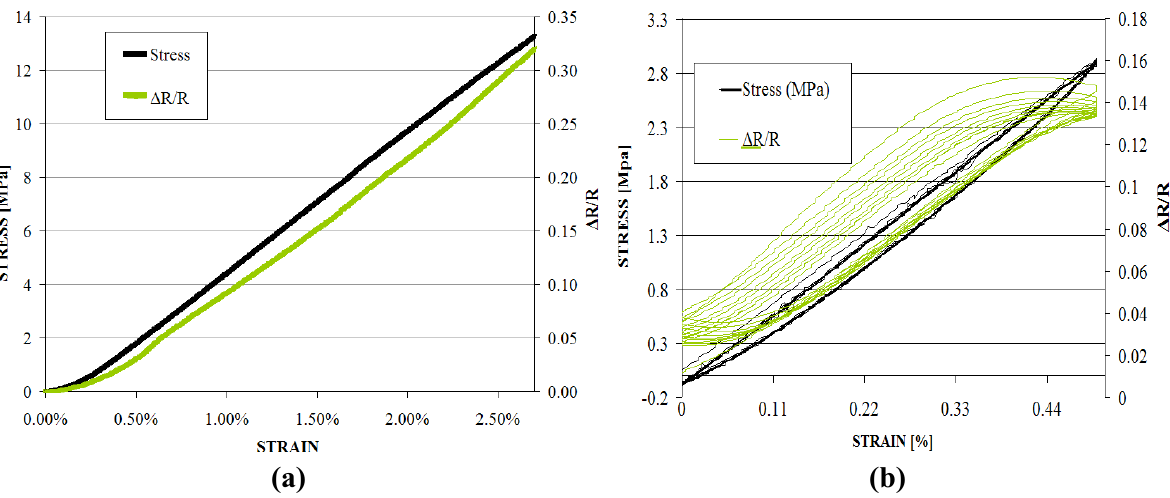
Figure 6. Normalized resistance and stress against strain for sensor outside